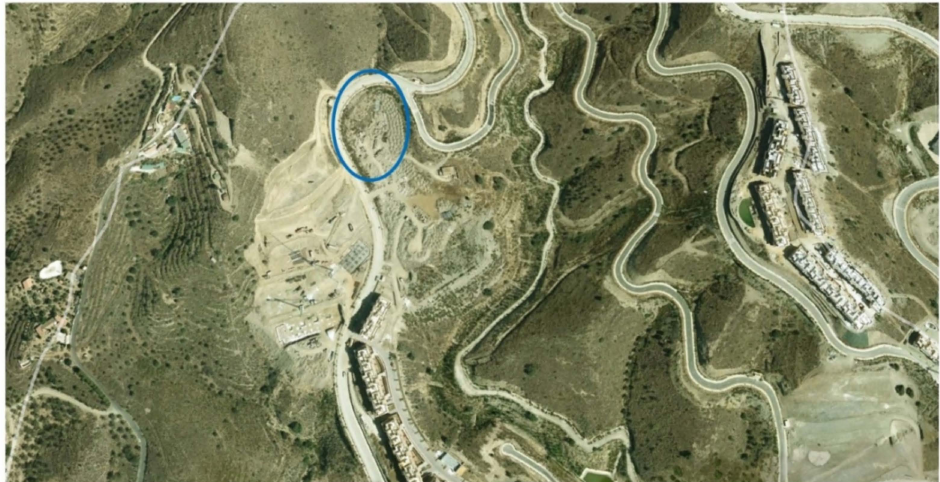
Figure 5. Partial image of the northern sector of the Piletas–Pollo Zamora basins, showing urban lands, plots in transformation, and areas with earthworks and accumulation of debris (blue circle). low